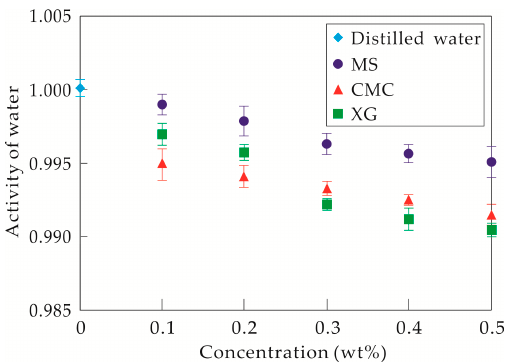
Figure 5. Water activity of each solution. MS: modified starch, CMC: carboxymethylcellulose sodium, XG: xanthan gum. Energies 2019 , 4 , x FOR PEER REVIEW